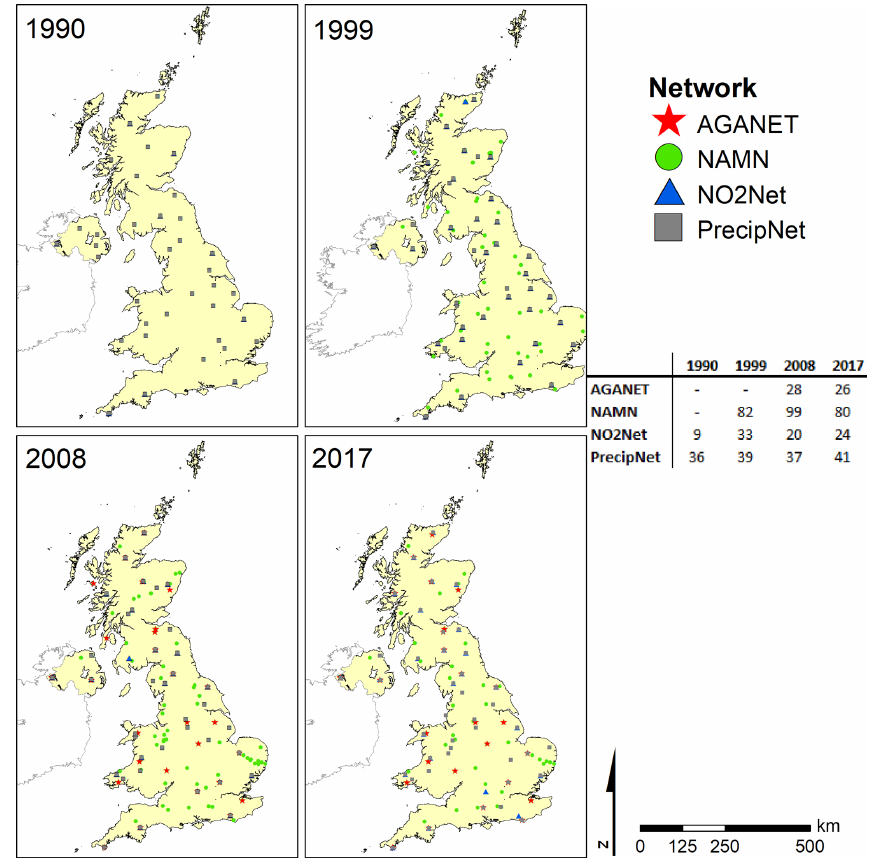
Figure 3. Locations of sites in four measurement networks, across four periods of the time series in this study: Acid Gases&Aerosol Net- work (AGANET), National Ammonia Monitoring Network (NAMN), Rural Background NO 2 (NO 2 NET) and Precipitation Network (Pre- cipNet). Some sites from different networks are co-located, and therefore not all dots represented in the table are visible in the maps.